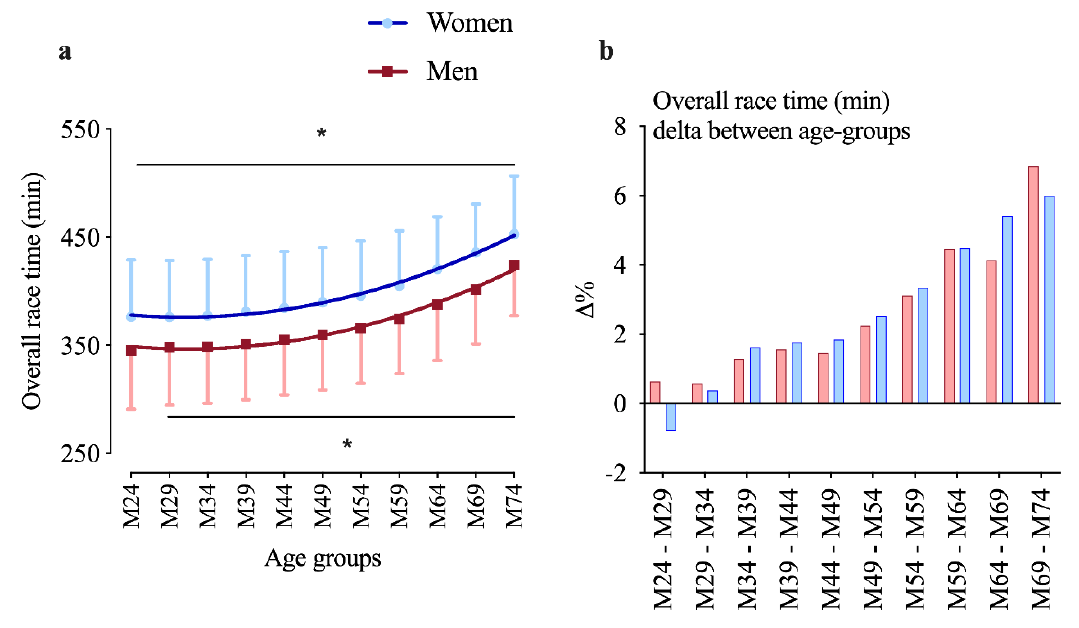
Figure 3. Overall race time; ( a , on the left): overall race time for both sexes; ( b , on the right): race time delta (%) between any two adjacent age groups; ( a, b ): men red, women blue. * Different from previous age group ( p < 0.05).